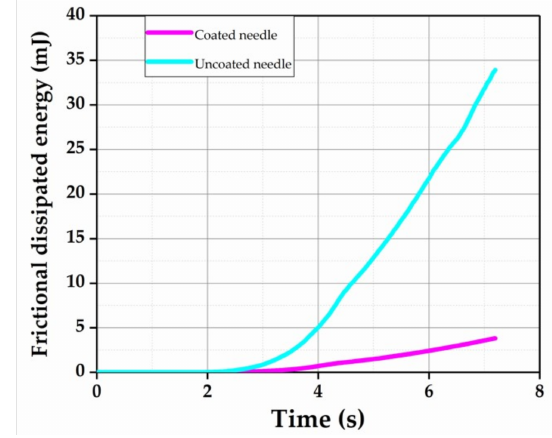
Figure 11. Frictional dissipated energy for the whole model.